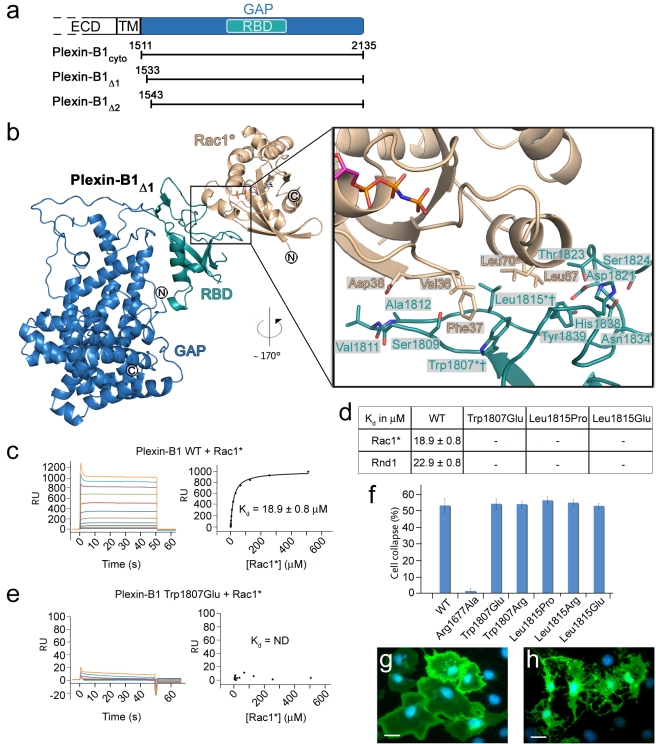
Structure of the monomeric Plexin-B1Δ1-Rac1* complex.